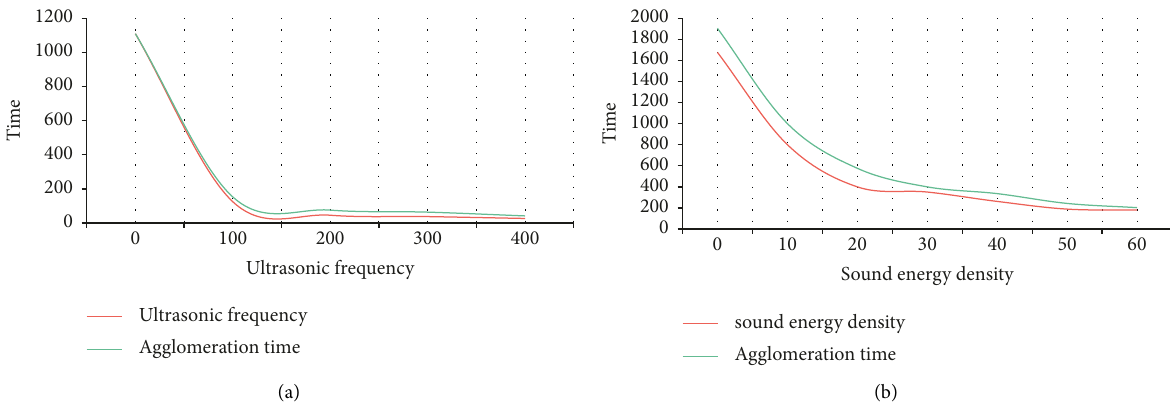
Figure 8: Relationship between acoustic energy density, ultrasonic frequency, and coagulation time under certain conditions.